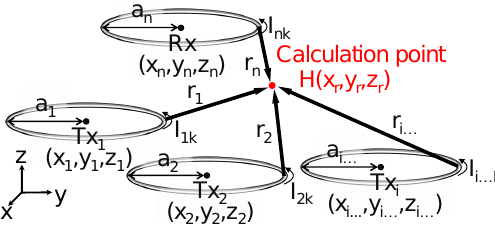
Figure 3. The magnetic field strength at the calculation point generated by each coil. It is calculated as the composite of the magnetic fields generated by all of the